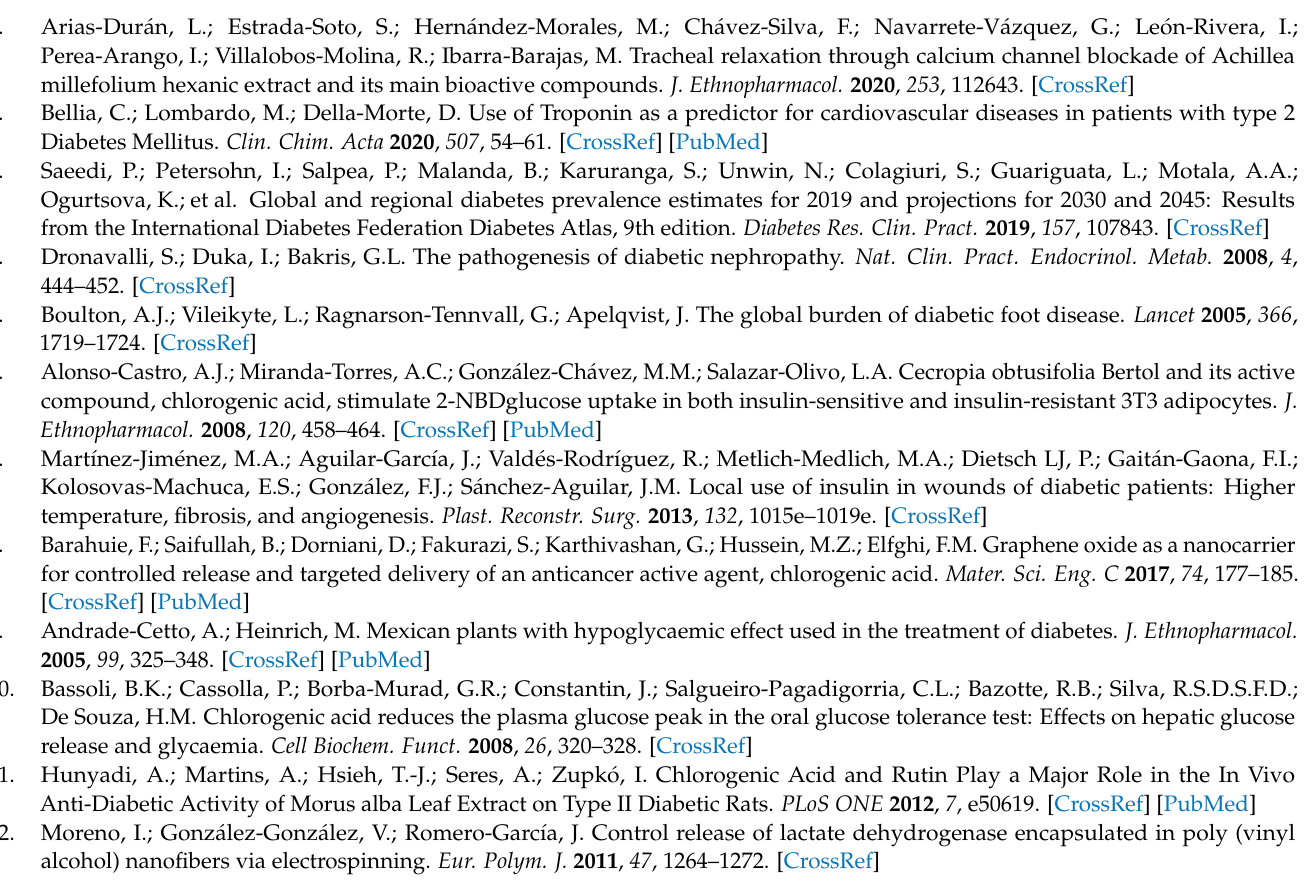
Table S1: Average pore size for PVA, PVA/ γ -PGA 5% and PVA/ γ -PGA